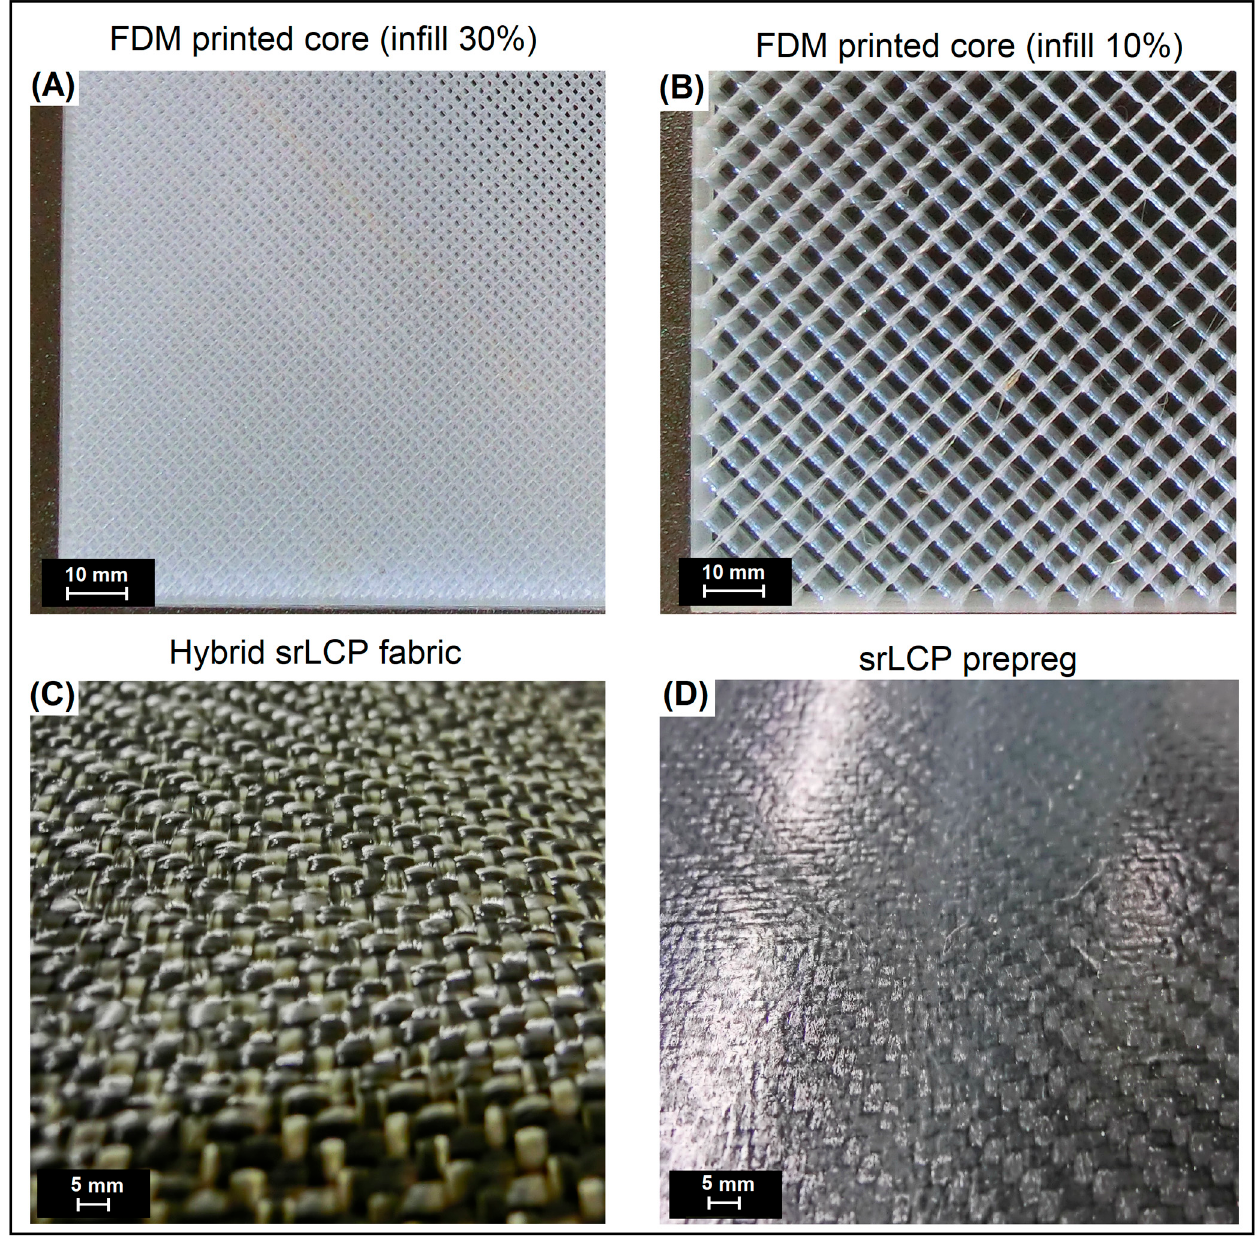
Figure 1. The appearance of the FDM-printed core structures: ( A ) 30% infill density and ( B ) 10% infill density; ( C ) the surface of the hybrid/commingled fabric; and ( D ) compression molded srLCP prepreg.